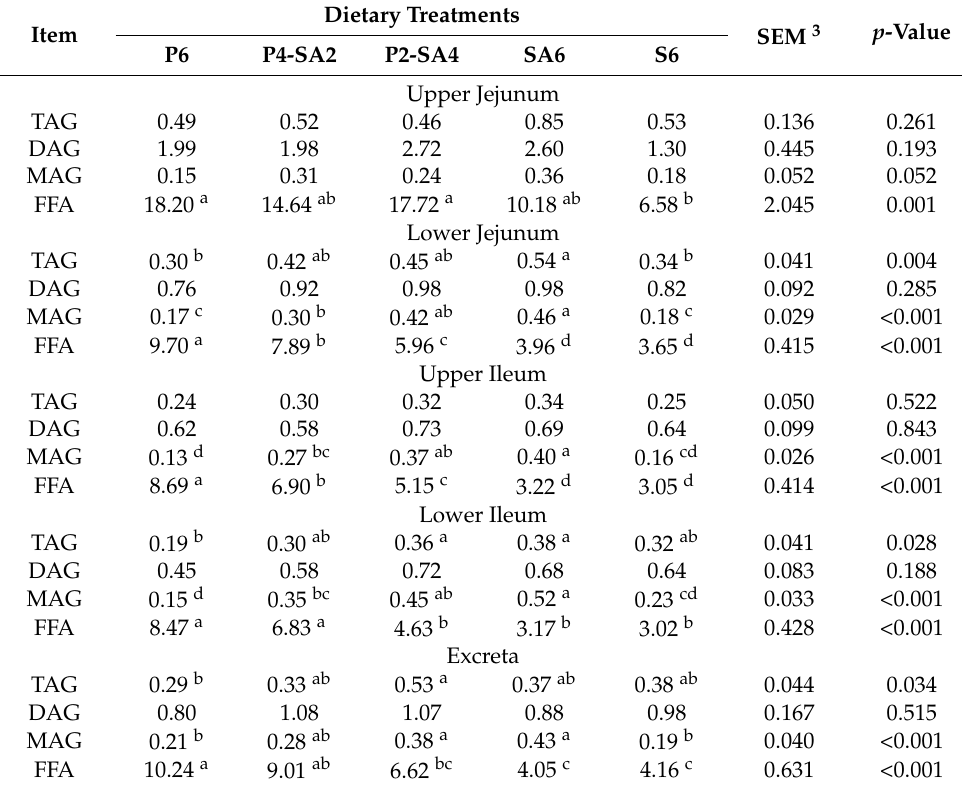
Table 5. Lipid class content 1 in the different intestinal segments and excreta in 11-d-old broiler chickens fed various experimental fat sources in the diet 2